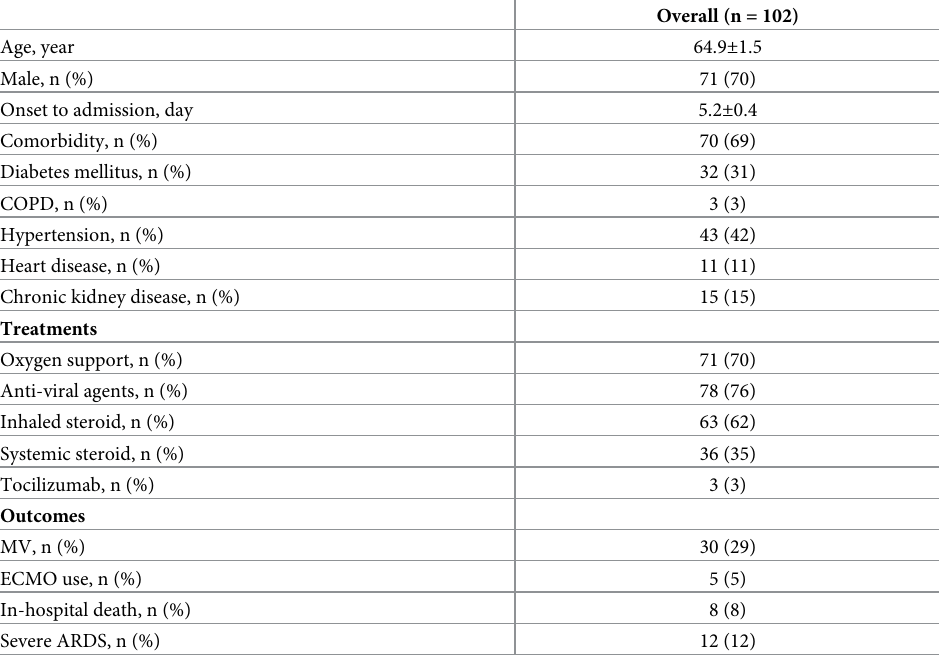
Table 1. Clinical features of patients with COVID-19 in this